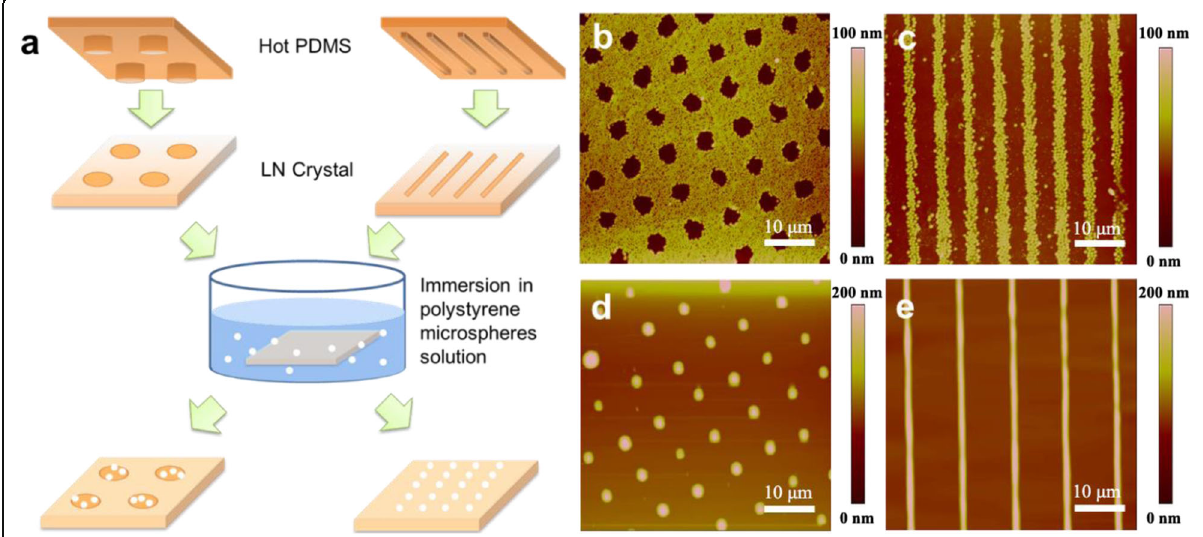
Fig. 2 The electrostatic interaction driven self-assembly ability of particles or thin polymer films by pyroelectric effects in micro-scale. a Schematic illustration shows the procedure of PS nanoparticles and film patterning self-assembly by using pyroelectrostatic charge interaction on the heated LN crystal wafers. Sixty nanometers of PS nanoparticles are chosen to characterize the charge pattern. The patterned assembly of PS nanoparticles b , c and the electrohydrodynamic assembly of thin PS film d , e on the pyroelectri c charge areas featured by